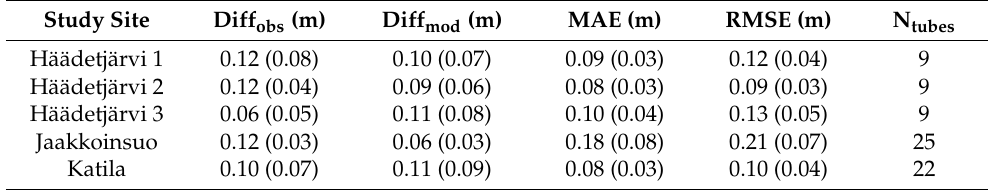
Table 3. Mean difference in the daily WTs between harvested strips and unharvested stands in May– November 2017–2020. Diff obs and Diff mod refer to observed and simulated differences, respectively. Groundwater tubes located at the edges of the strips were not included in the figures. The average mean absolute errors (MAEs) and root mean square error (RMSE) for the simulated WTs are also presented for the study areas. The standard deviation for each mean value is presented in parenthesis. N tubes refer to the total number of